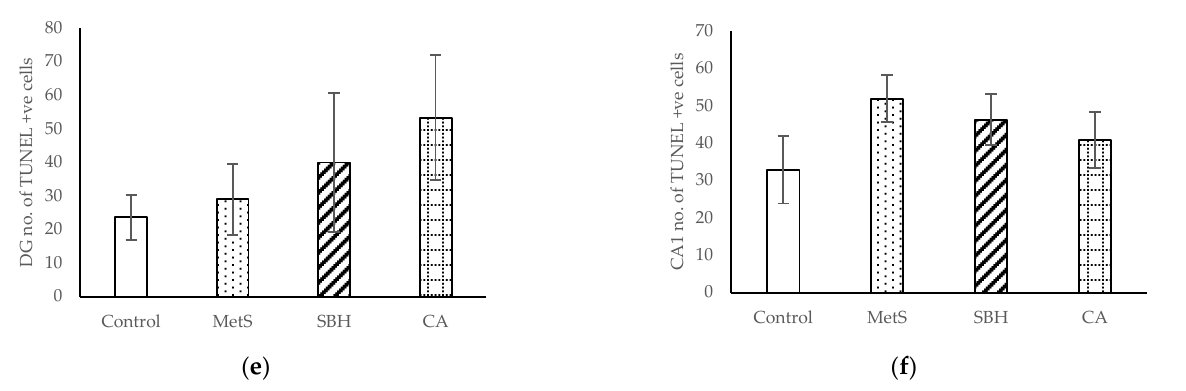
Figure 5. Photomicrographs ( a , d ) show the hippocampal areas CA1 and DG, respectively, in the brains of the experimental rats: ( a ) cells undergoing DNA replication tagged by EdU in green (white arrowheads); number of EdU-positive cells in ( b ) DG and ( c ) CA1; ( d ) cells undergoing apoptosis stained by TUNEL are seen as red (white arrowheads); number of TUNEL-positive cells in ( e ) DG and ( f ) CA1. Data are presented as mean ± SEM ( n = 3). * p < 0.05. TUNEL assay was used to label cells that underwent apoptosis.